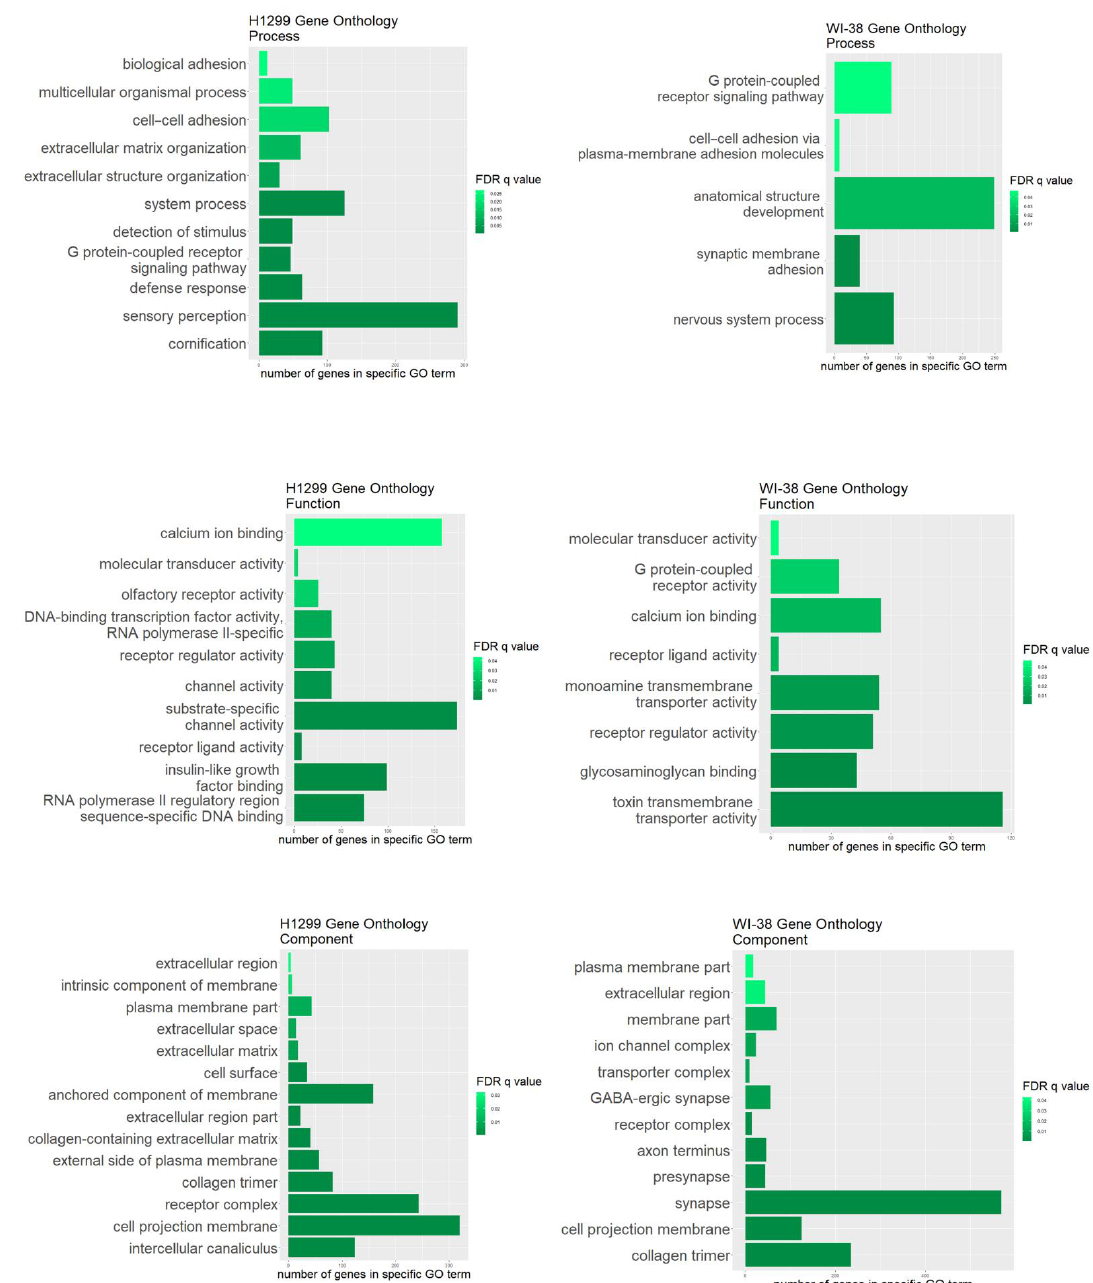
Figure 7. Results of the gene ontology analysis of the differentially expressed genes in H1299 and WI-38 cell lines overexpressing TLR5 N592S variant. Statistically enriched process, function and component GO terms are shown and ranked based on the false discovery q-value.